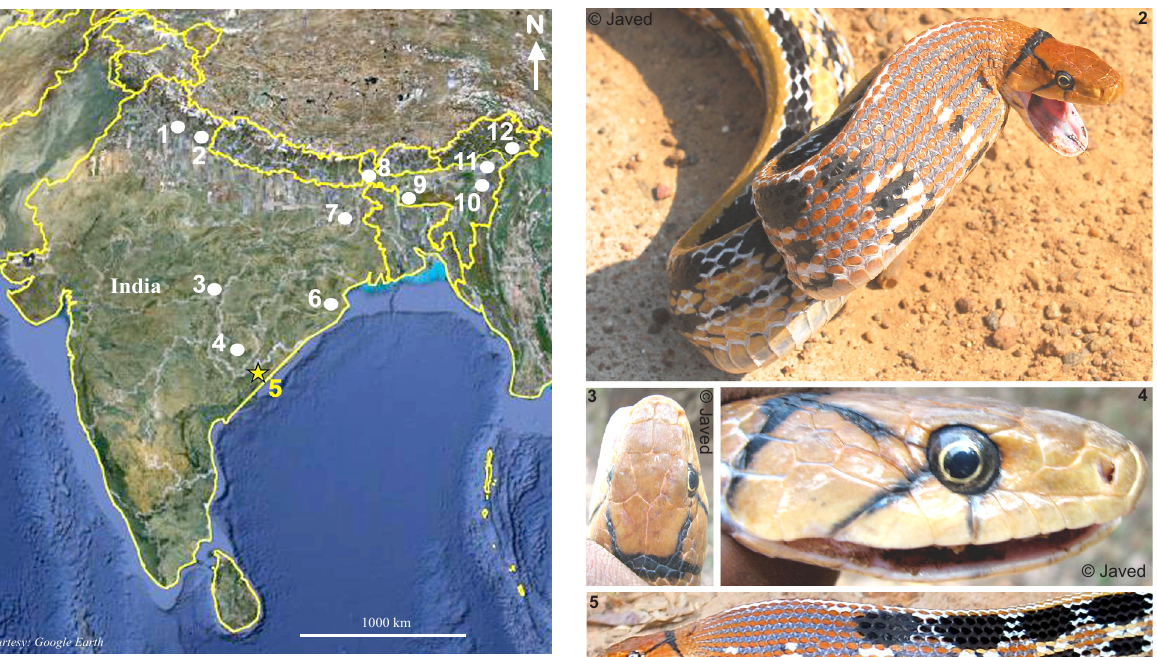
Image 1. Satellite image showing a map depicting C. radiatus distribution range in India. 1- Dehradun; 2 - Almora; 3 - Balaghat; 4 - Bastar; 5 - Ananthagiri (present study); 6 - Cuttack; 7 - Purnia; 8 - Darjeeling; 9 - Meghalaya; 10 - Dibrugarh; 11 - Kohima; 12 - Miao.